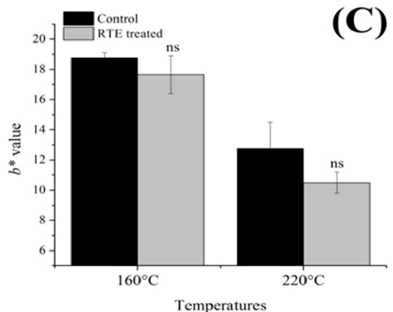
Figure 5. Effects of the Rosa rugosa tea extract (RTE) on the color value; ( A – C ) for L * , a * , and b * , respectively; means ± SD of triplicate analyses; ns = not significant ( p > 0.05).